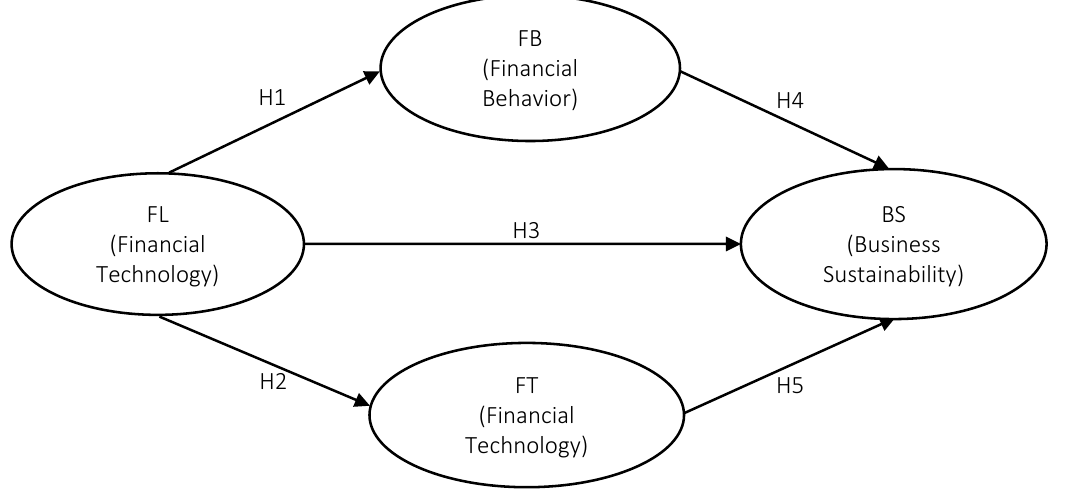
Figure 1. Conceptual